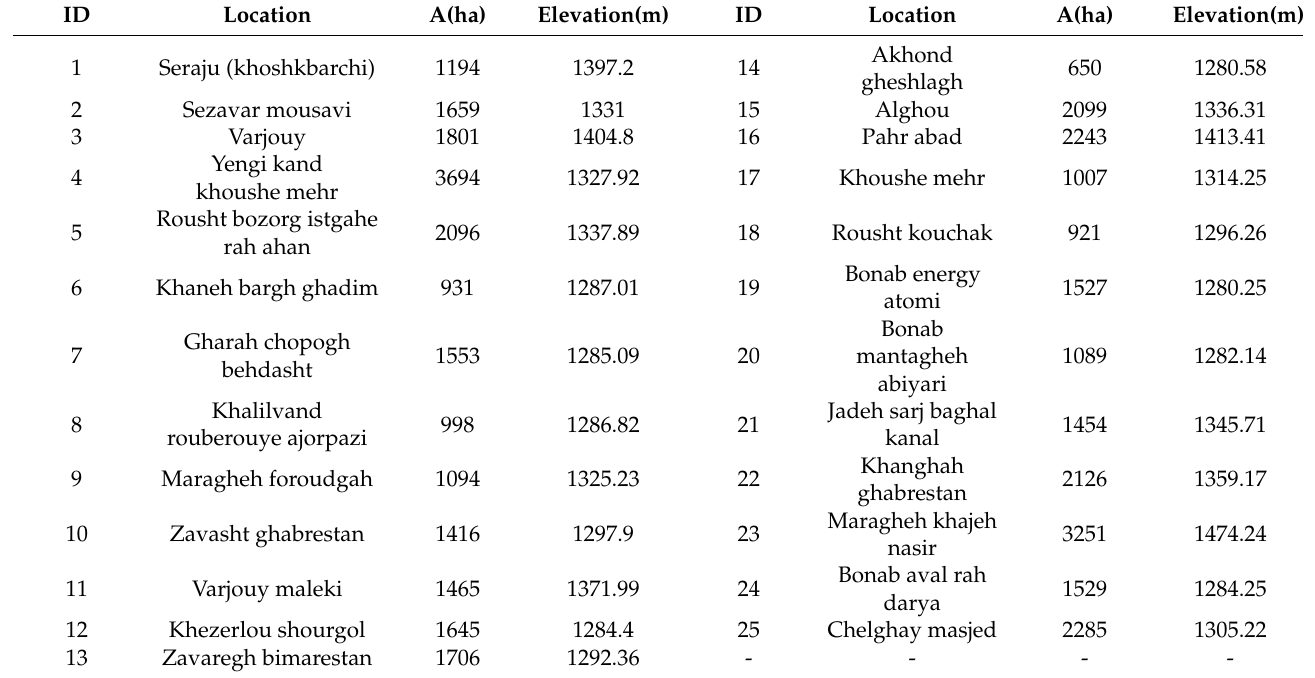
Table 1. List of the 25 wells and the areas of their Theissen polygons.